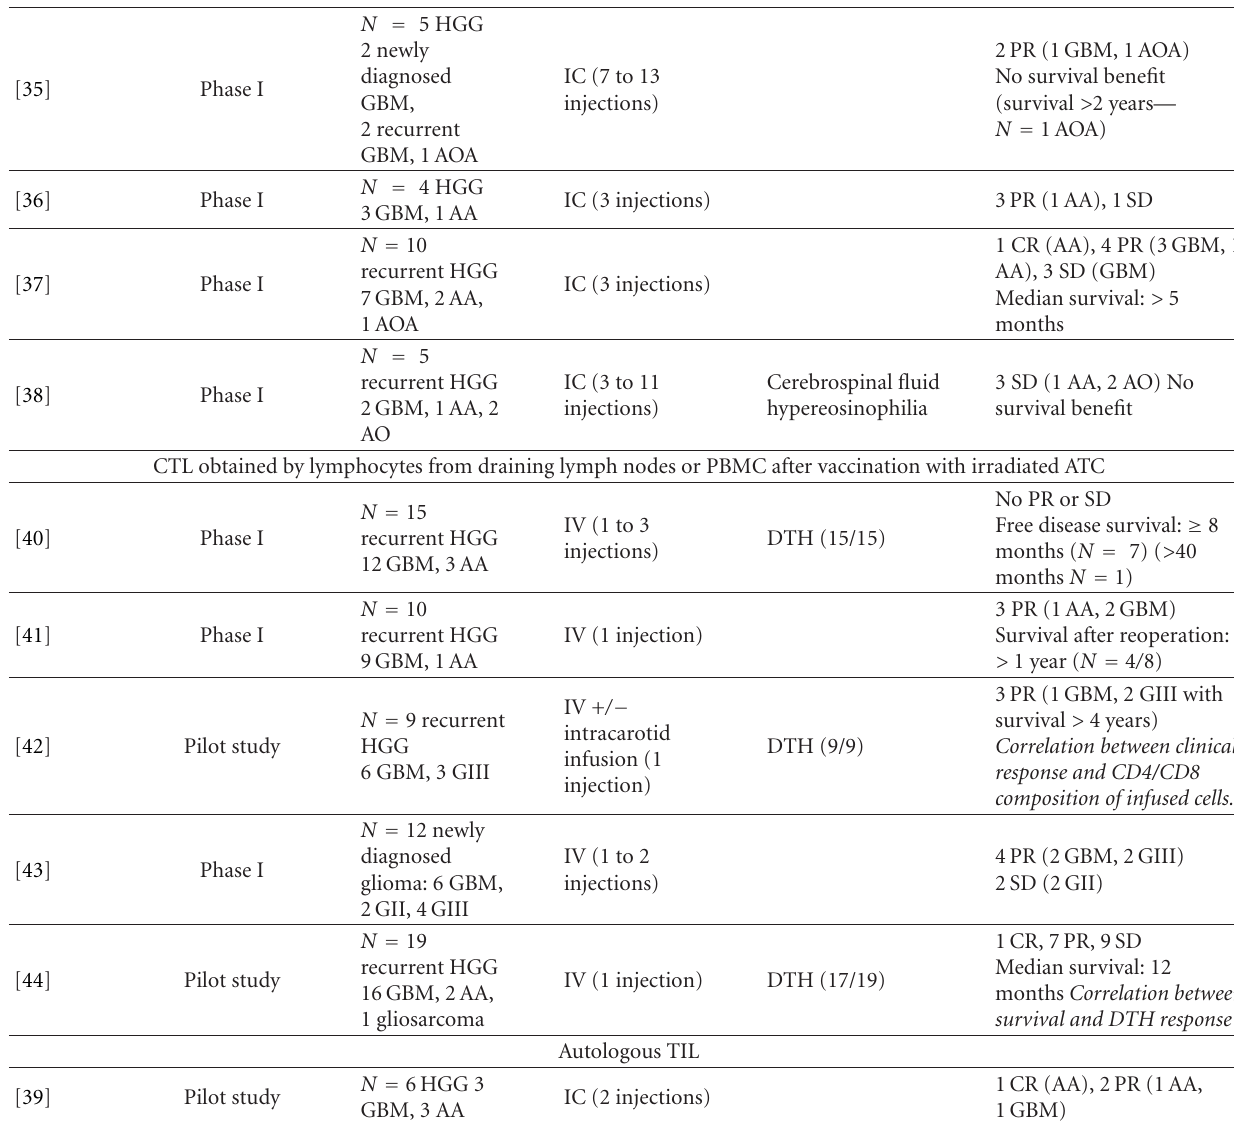
∗ : Abbreviations used in this table: see Table 1; DTH: delayed-type hypersensitivity; PBMC: peripheral blood mononuclear cells; IV: intravenous. used alone and injected in the presence of di ff erent adjuvants or presented on DCs which play a key role in initiating the immune